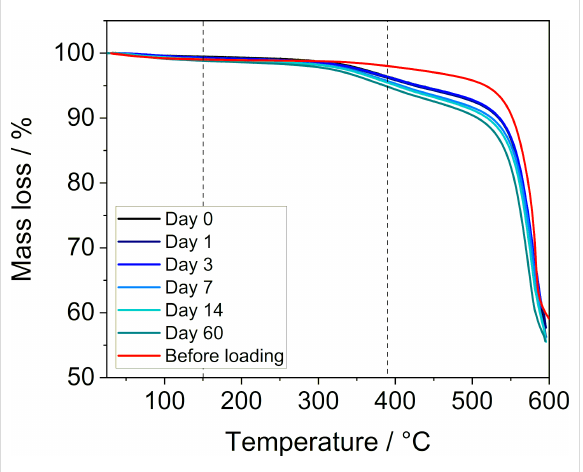
Figure 6: Thermogravimetric analysis of MFU-4 loaded with SF 6 (Sample 3a) after 0, 1, 3, 7, 14, and 60 days measured under a nitrogen atmosphere at a heating rate of 10 K min − 1